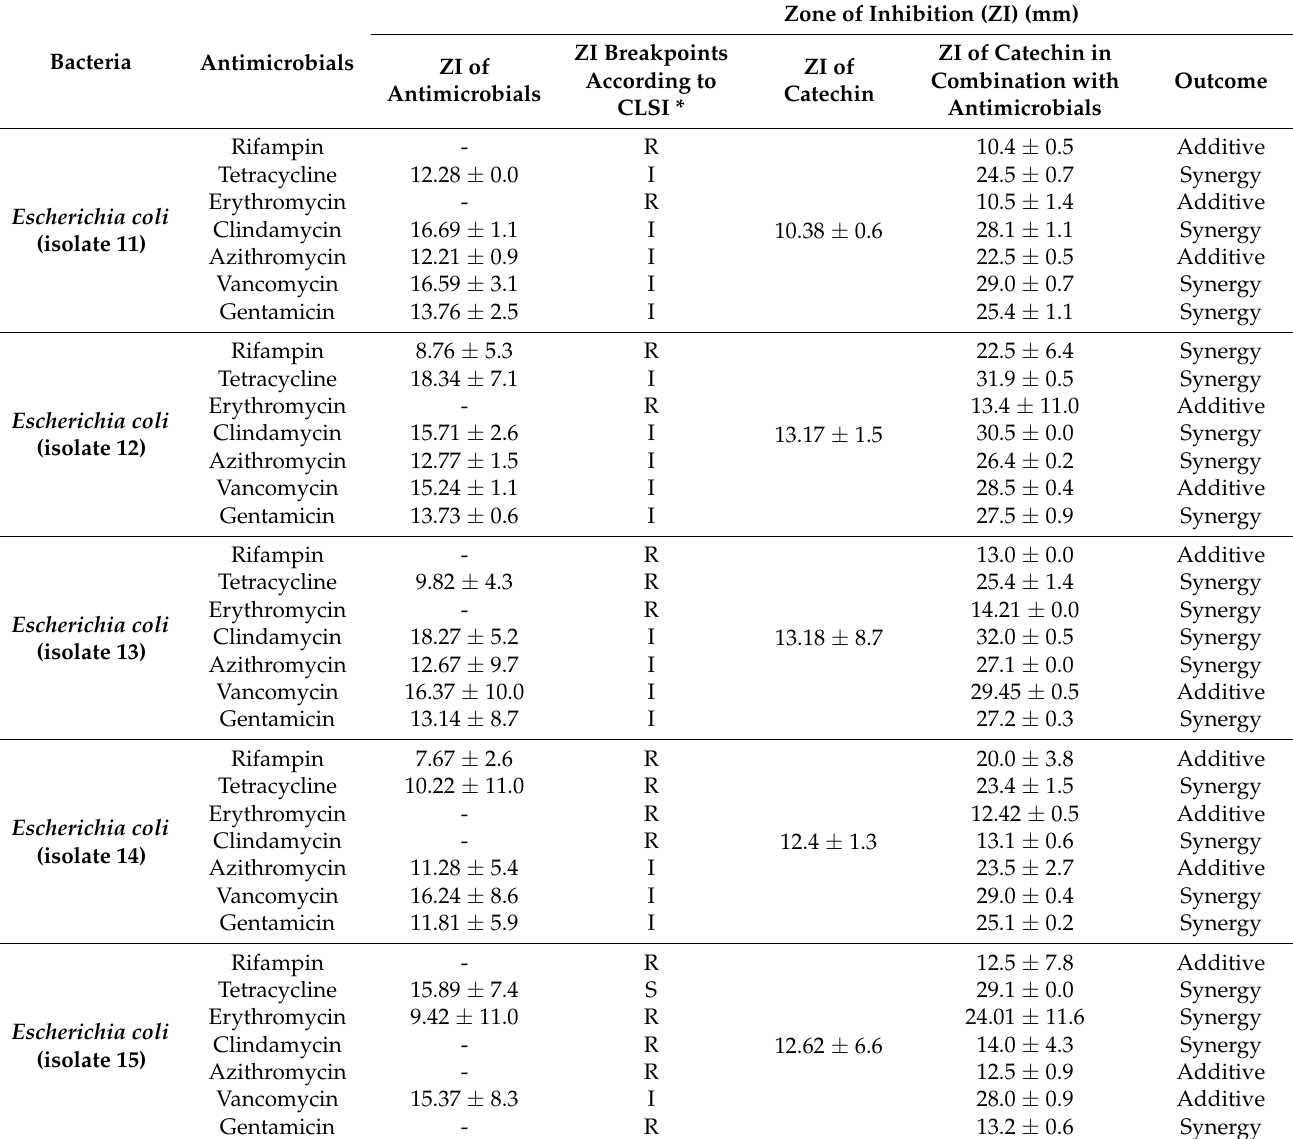
“#” means statistical data are unavailable, “-” means no activity, and “*” indicates that the results are categorized according to Clinical and Laboratory Standards Institute (CLSI) guidelines into R resistant; I